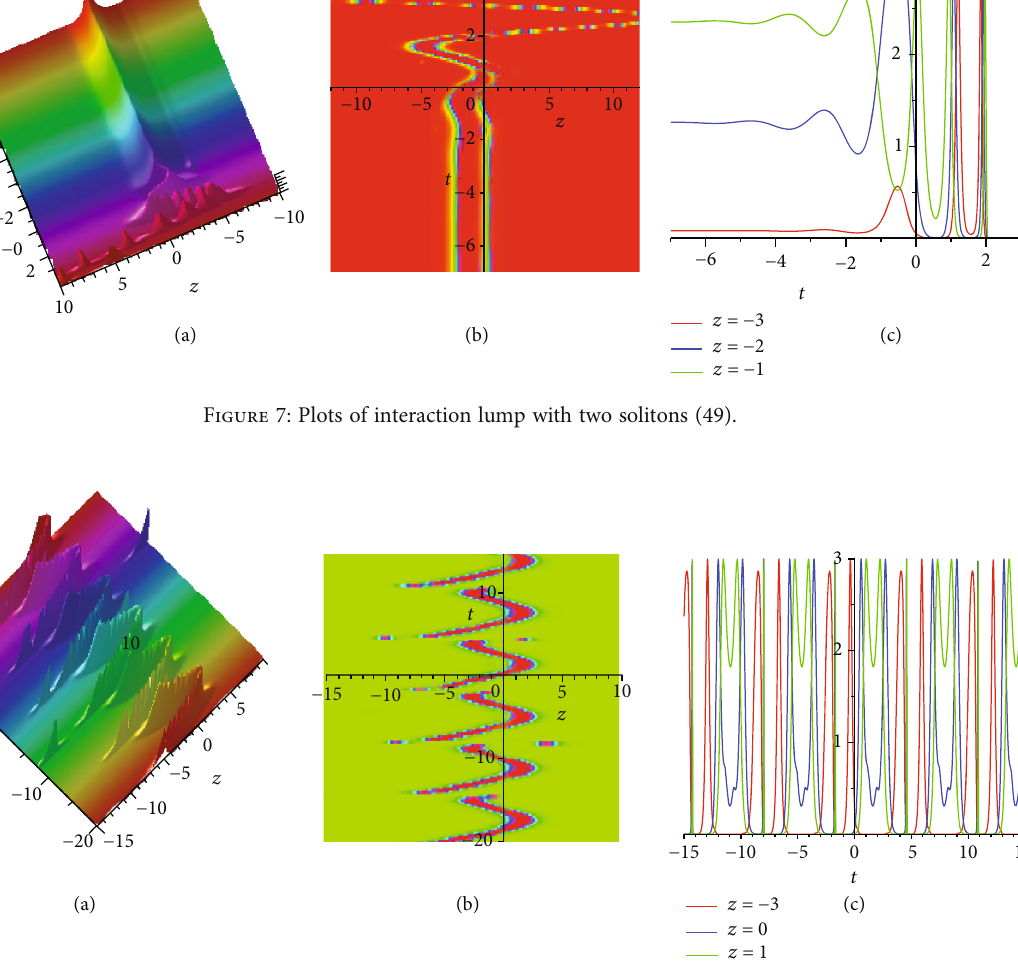
Figure 8: Plots of interaction lump with two solitons